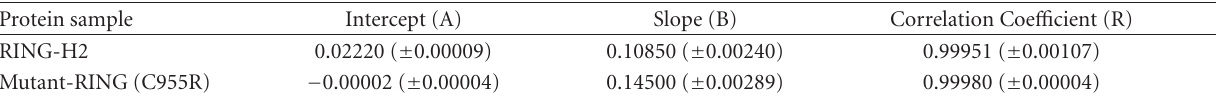
Table 3: Linear regression data for the calibration